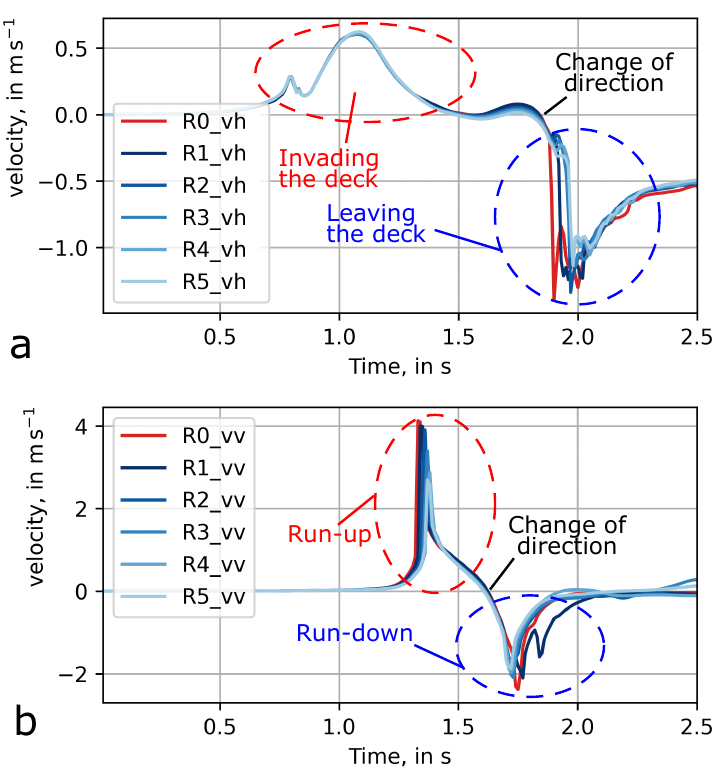
Figure 9. Effect of deck roughness on shipping water velocities. ( a ) Time series of horizontal velocity ( v h ) at the deck edge for different roughnesses. ( b ) Time series of vertical velocity ( v v ) close to the deck wall for different